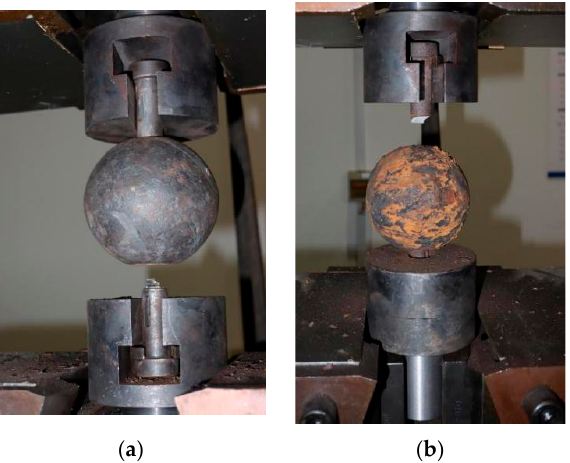
Figure 7. Failure modes: ( a ) uncorroded specimen; ( b ) corroded specimen.